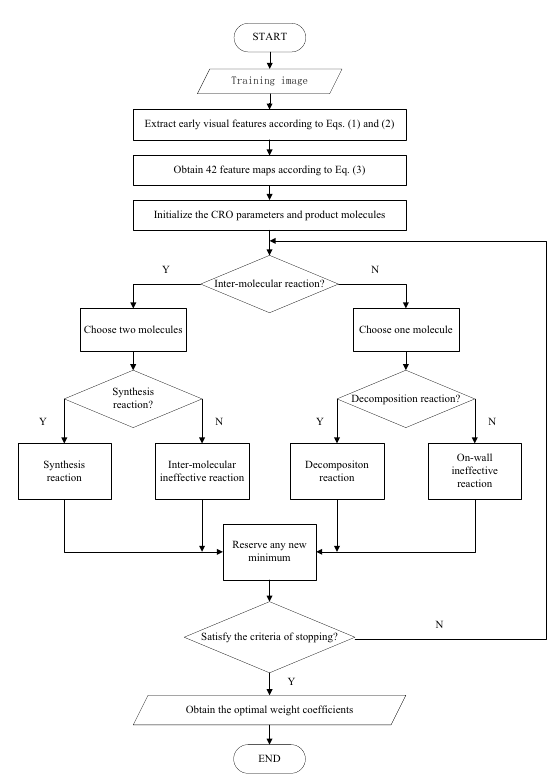
Fig. 3. Flow chart of the training procedure using CRO algorithm.